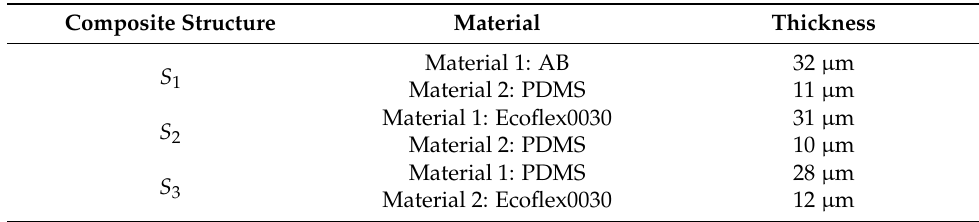
Table 2. Diaphragm thickness of each composite structure with different materials.